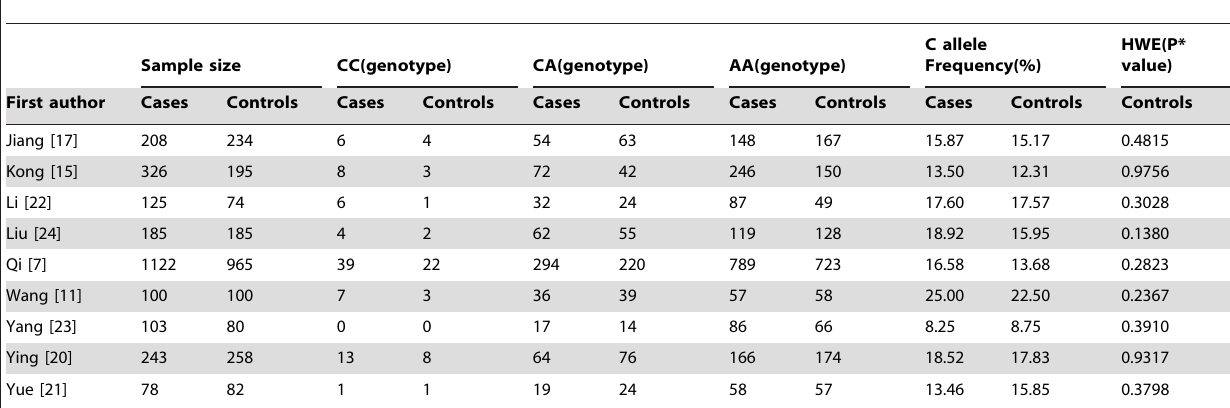
Table 4. Sample size, the distribution of A-20C genotypes and allele frequencies, and P-values of HWE.